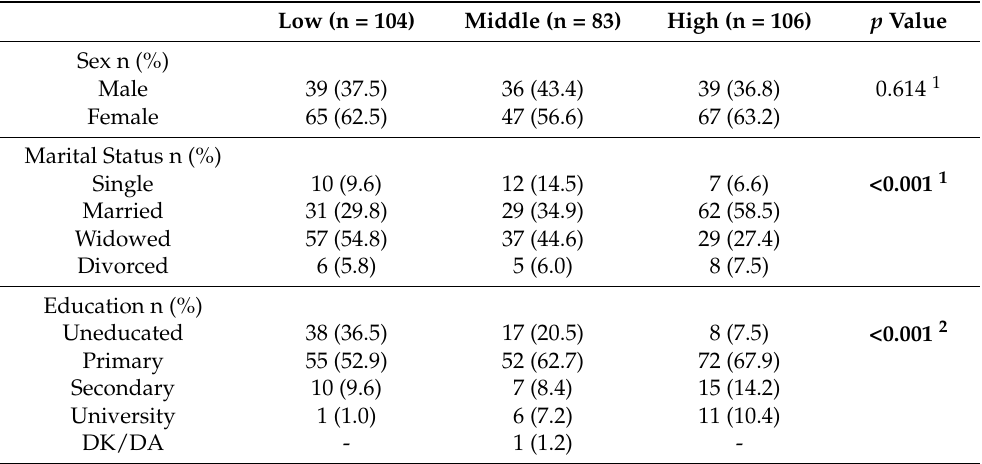
Table 2. Sociodemographic and personal variables according to the level of acceptability of the use of new technologies. Low (n = 104)